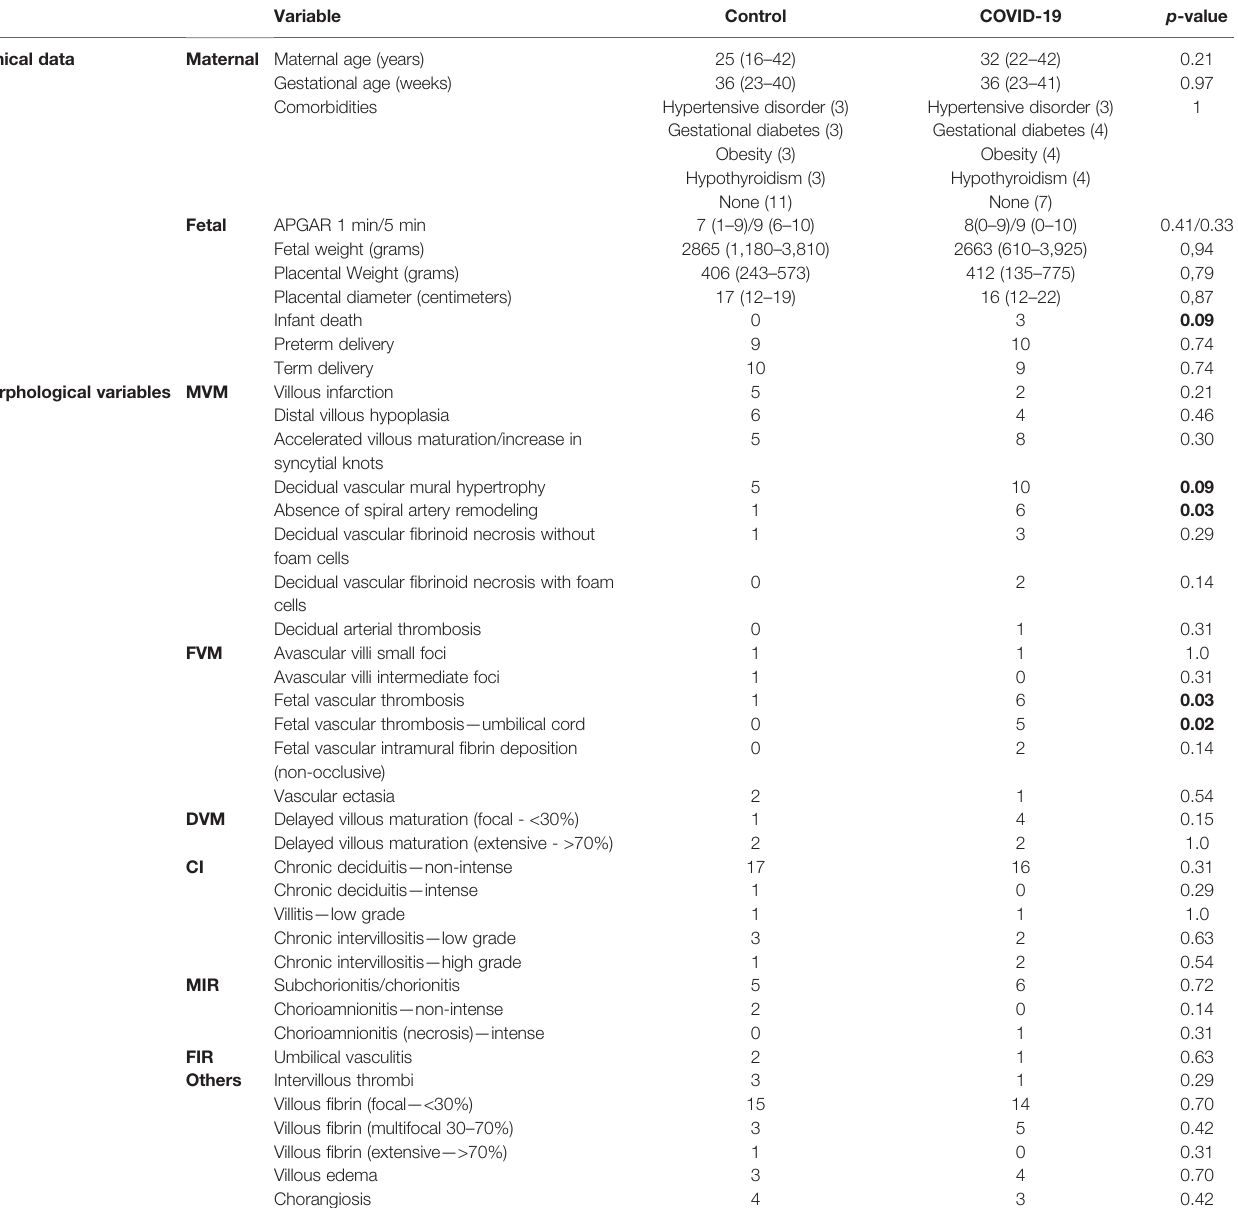
TABLE 3 | Clinical and morphological comparisons between COVID-19 group (n=19) and Control group (n=19)